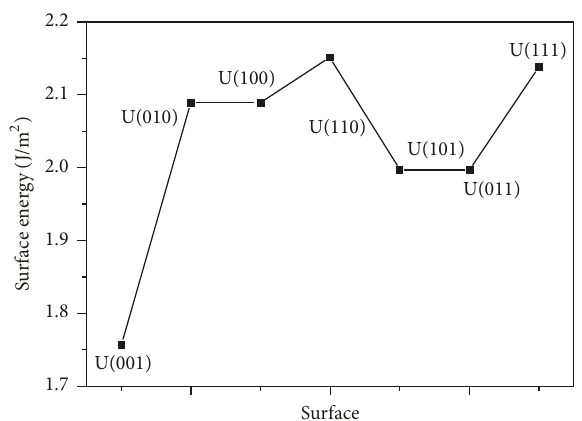
Figure 6: Variation of surface energies of seven basic uranium surfaces. Table 4: Surface energy ( Γ ) and work function ( B ). Surface